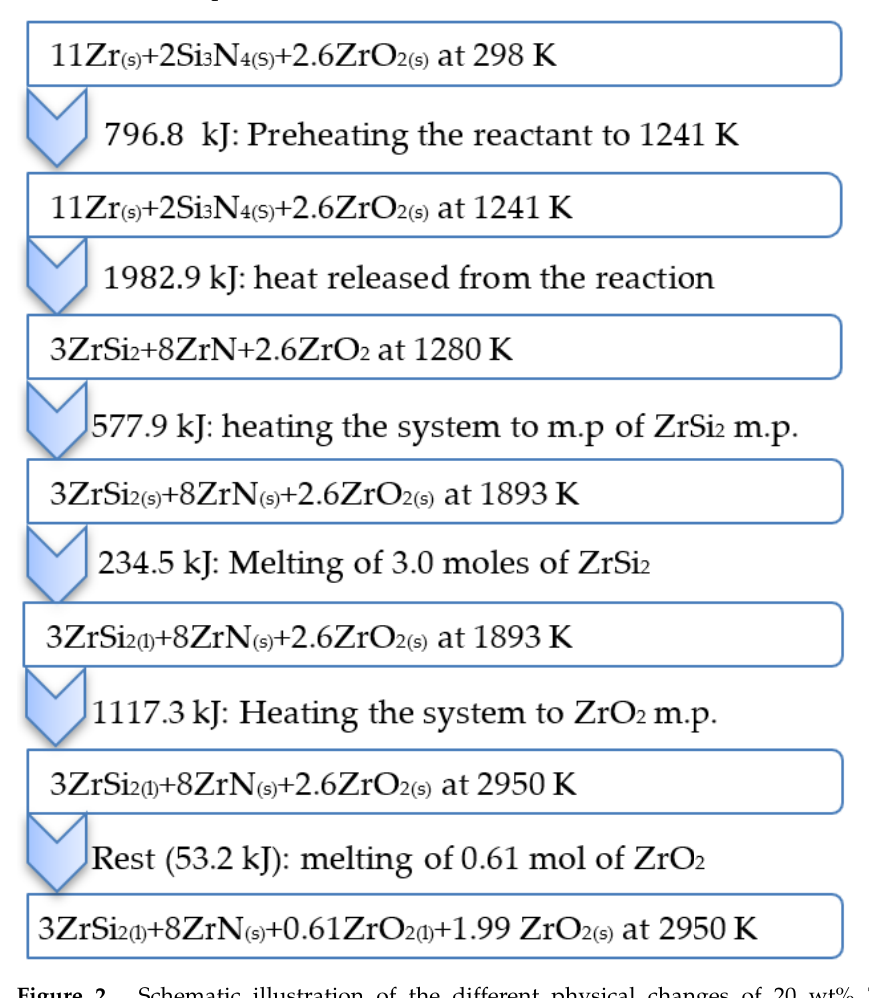
Figure 2. Schematic illustration of the different physical changes of 20 wt% ZrO 2 -sample (2.6 mol ZrO 2 ).